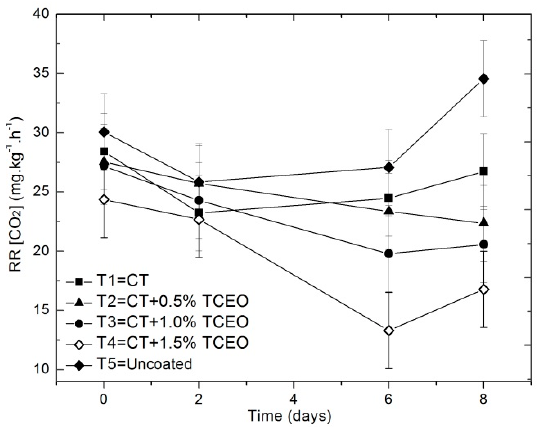
Figure 8. Evolution of respiration rate in strawberries with chitosan (CT) and treatments of oil (TCEO): T1 = CT, T2 = CT + 0.5% of TCEO, T3 = CT + 1.0% of TCEO, T4 = CT + 1.5% TCEO, and T5 = uncoated. Mean values and intervals of Fisher’s LSD of 95% according to the ANOVA test.